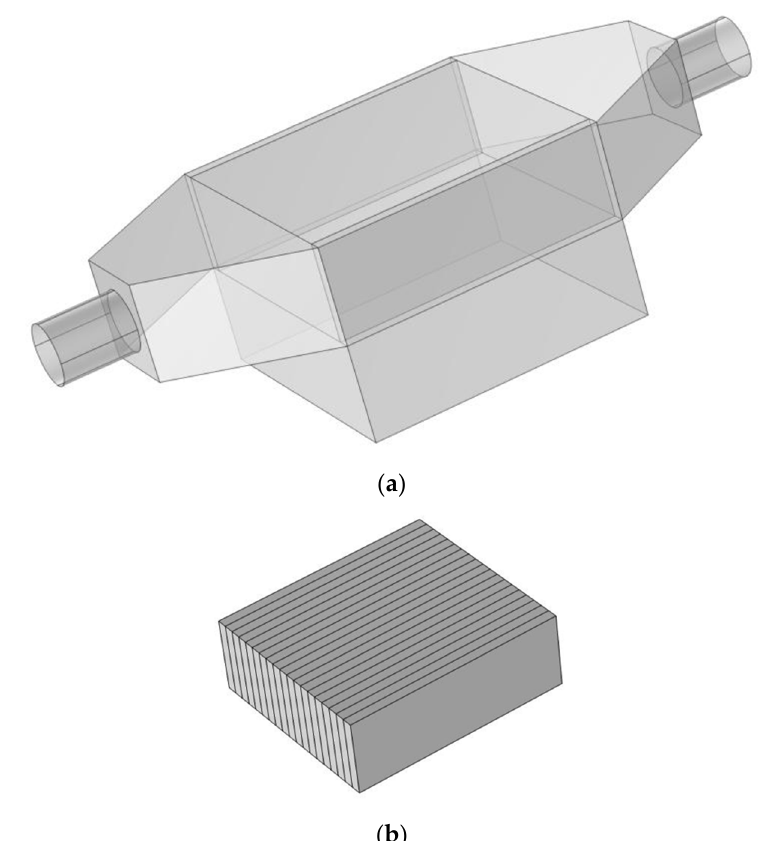
Figure 2. Geometrical model with different inserts. ( a ) Experimental setup; ( b ) Insert mini channels.